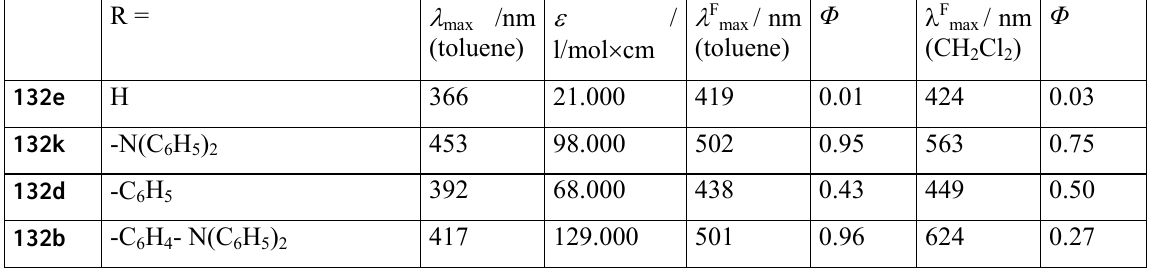
Table 10. Optical data of substituted hexaphenylhexaazatriphenylenes 132 . R